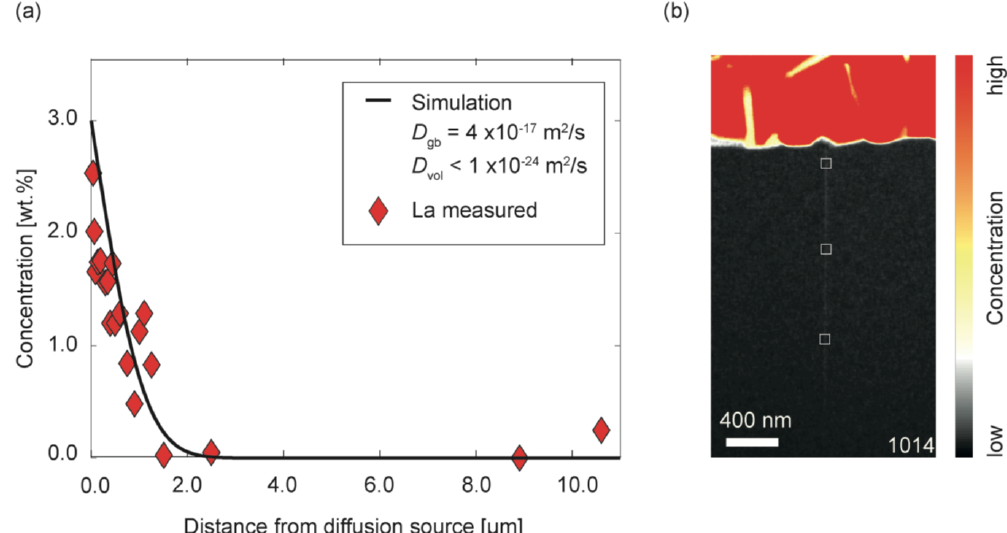
Figure 9. (a) La concentration profile along grain boundary of sample TH_9_5 (1014) in wt.%. Each diamond shows the quantitative concentration of La (signals were integrated over 8 × 8nm) at the respective distances from the groove. This is indicated schematically in (b) . (b) Element concentration map of La. Red indicates high concentrations and black indicates low concentrations of